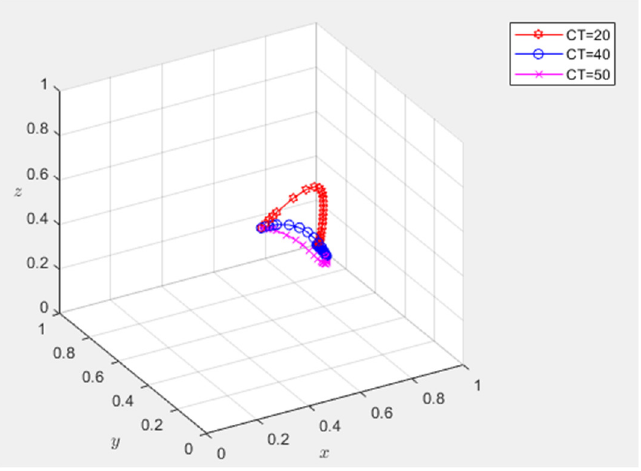
Figure 6. Influence of quality inspection cost.